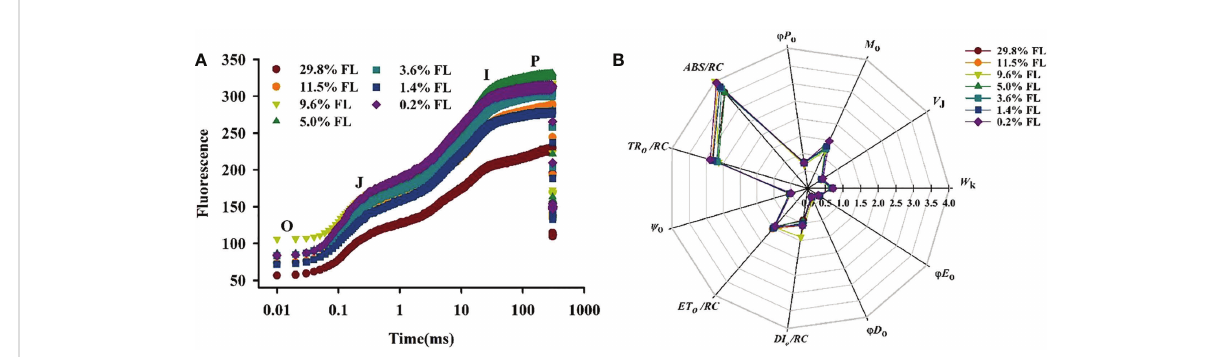
FIGURE 10 Effects of light regimes on chlorophyll fl uorescence transients of P. notoginseng. (A) O, J, I and P phase represent the fl uorescence at T=20 m s, 2 ms, 30 ms and 300 ms, respectively. (B) A radar plot of JIP parameters in P. notoginseng leaves grown under different light regimes. ABS/RC is the absorption fl ux per reaction center of PSII; TR o /RC is the captured light energy used to restore q A ; ET o /RC is the captured light energy used for electron transfer per unit area; DI o /RC is the energy dissipated per unit reaction; Y o is the probability that a trapped exciton moves an electron into the electron transport chain beyond Q (cid:1) A (at t =0); M o is the approximated initial slope of the fl uorescence transient; V J is the relative variable fl uorescence intensity at the J-step; W k is the K phase in O-J-I-P chlorophyll fl uorescence induction curves; j D o is the quantum yield for thermal dissipation; j E o is the quantum yield for electron transport ( t = 0); j P o is the maximum quantum yield for primary photochemistry ( t = 0). Values for each point were means ( n =